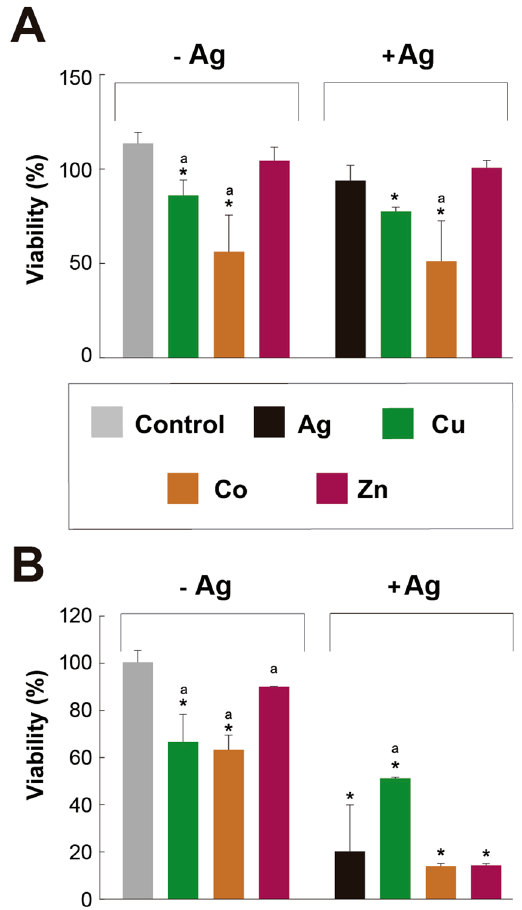
Figure 10. Cytotoxicity effects of Ag and transition metals at concentrations adjusted for speciation on melanocytes and myoblast cells. Effect of transition metals, alone or in combination, with Ag on the viability of ( A ) B16F10 and ( B ) H9c2 cells. Cells were treated with each transition metal (in nominal µ M: Cu 80; Co 400; Zn 31.2) alone or in the combination with Ag (15 µ M), for 24 h. Values are mean ± SD. * p < 0.05 vs. Control; (a) vs. Ag. (n = 3 experiments at least for each